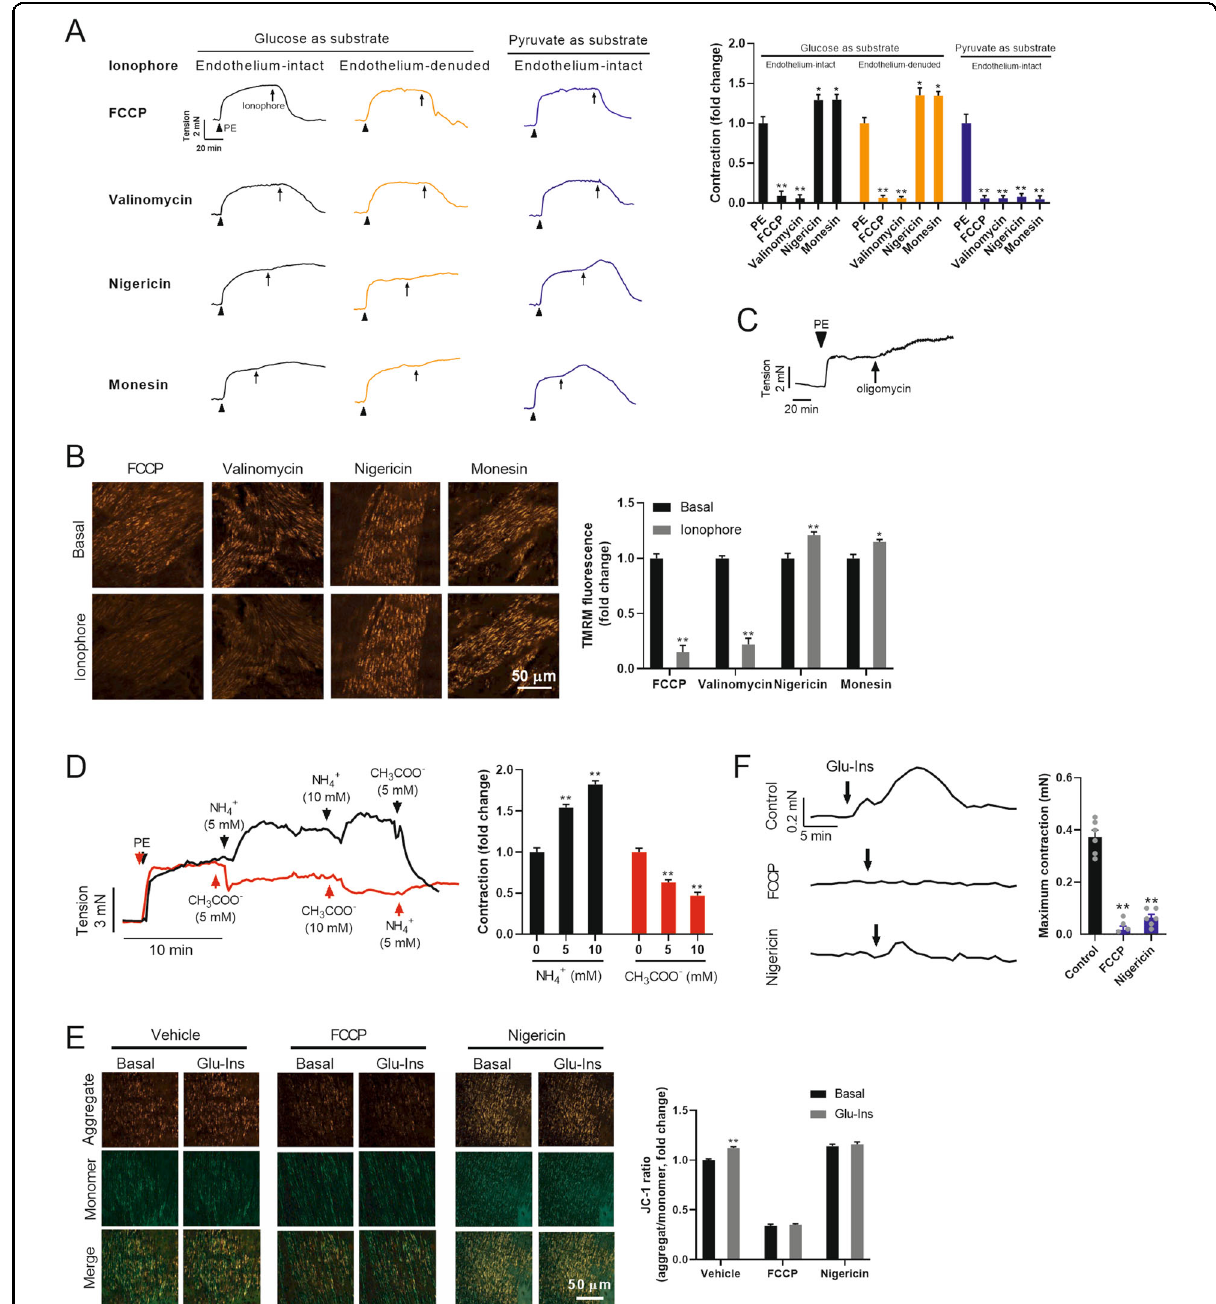
Fig. 3 ΔΨ m positively regulates VSMC contraction. A The effects of four ionophores on vascular constriction in isolated thoracic aortas with intact endothelium or with denuded endothelium. The aortas were pretreated with PE. Glucose (5mM) or pyruvate (5mM) was supplied as the only metabolite available in the incubation medium. Typical traces of vascular tension were shown in the left, and the quanti fi ed results were shown in right. The arrow indicates the time point for treatment with ionophore. n = 6. B The effects of four ionophores on ΔΨ m in VSMCs of isolated aortas. Typical images of ΔΨ m in VSMCs in blood vessels were shown in the left, and the quanti fi ed results were shown in right. ΔΨ m was detected by TMRM. n = 6. C Oligomycin induced vascular constriction in isolated thoracic aortas. D The effects of NH 4 + and CH 3 COO - on vascular tone in isolated aortas. Typical traces of vascular tension were shown in the left, and the quanti fi ed results were shown in right. n = 6. E Glu-Ins-induced mitochondrial hyperpolarization was blocked by preincubation of isolated aortas with FCCP or nigericin. ΔΨ m was detected by JC-1. Typical images of ΔΨ m in VSMCs in blood vessels were shown in the left, and the quanti fi ed results were shown in right. F Preincubation of isolated aortas with FCCP or nigericin inhibited Glu-Ins-induced vascular constriction. Typical traces of vascular tension were shown in the left, and the quanti fi ed results were shown in right. n = 6. Error bars represent SEM. * P <0.05. ** P